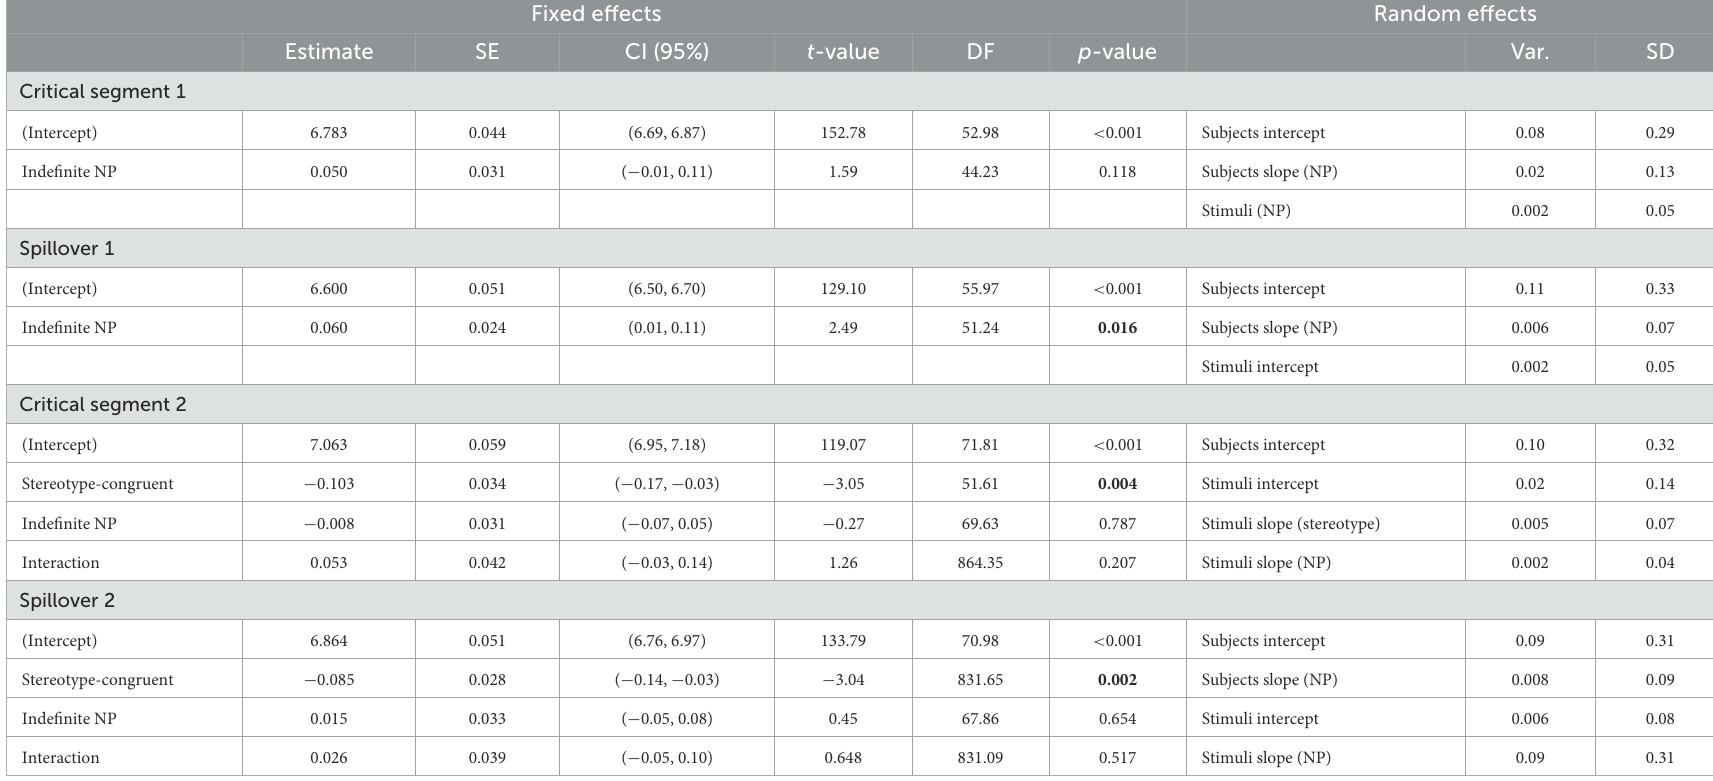
TABLE 7 Statistical results of the selected parsimonious models for Experiment